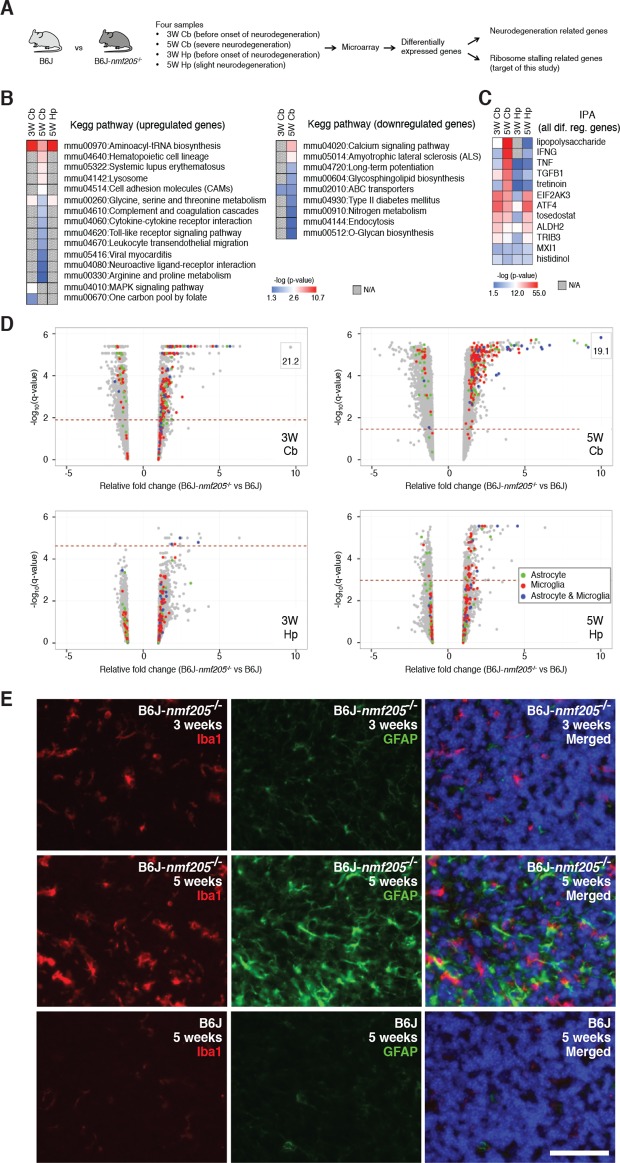
Transcriptional profiling of B6J-Gtpbp2nmf205-/- mutant mice.(A) To segregate genes associated with ribosome stalling from genes nonspecifically induced during neurodegeneration, microarray analysis was performed on the cerebellum (Cb) and hippocampus (Hp) from B6J and B6J-Gtpbp2nmf205-/- (B6J-nmf205-/-) mice at 3-weeks (3W) and 5-weeks (5W) of age. (B) Enriched pathways among genes that were up or downregulated in the B6J-Gtpbp2nmf205-/- brain were obtained by Kegg pathway analysis. Note that upregulated gene pathways exhibited more robust p-values. (C) Ingenuity Pathway Analysis (IPA) upstream regulator analysis of B6J-Gtpbp2nmf205-/- upregulated genes demonstrates ATF4 and EIF2AK3 activation in the 3- and 5-week hippocampus and cerebellum. Inflammatory-related upstream regulators are also strongly activated of in the 5-week-old mutant cerebellum. (D) Volcano plots of –log10q-values and relative fold changes of all genes. Genes previously shown to be expressed in microglia (red), astrocytes (green), or in both microglia and astrocytes (blue) are indicated, with all other genes shown in gray. Genes with very high levels of induction are shown in boxes to fit on the scale. The horizontal dashed lines indicate a false discovery rate of 0.1. Note the strong induction of genes activated in both microglia and astrocytes in the 5-week-old B6-Gtpbp2nmf205-/- cerebellum. (E) Immunofluorescence using antibodies to Iba1 (microglia) and GFAP (astrocytes) was performed on sections of B6J and B6J-Gtpbp2nmf205-/- cerebellum at indicated ages. Microglia and astrocytes were activated in the mutant cerebellum with highest levels of activation at 5 weeks of age. Sections were counterstained with Hoechst 33342 to visualize nuclei as shown in merged. Scale bar, 50 μm.DOI:
http://dx.doi.org/10.7554/eLife.14295.00310.7554/eLife.14295.004Figure 1—source data 1.Significantly changed genes.DOI:
http://dx.doi.org/10.7554/eLife.14295.00410.7554/eLife.14295.005Figure 1—source data 2.GO & IPA analysis.DOI:
http://dx.doi.org/10.7554/eLife.14295.00510.7554/eLife.14295.006Figure 1—source data 3.Inflammatory genes.